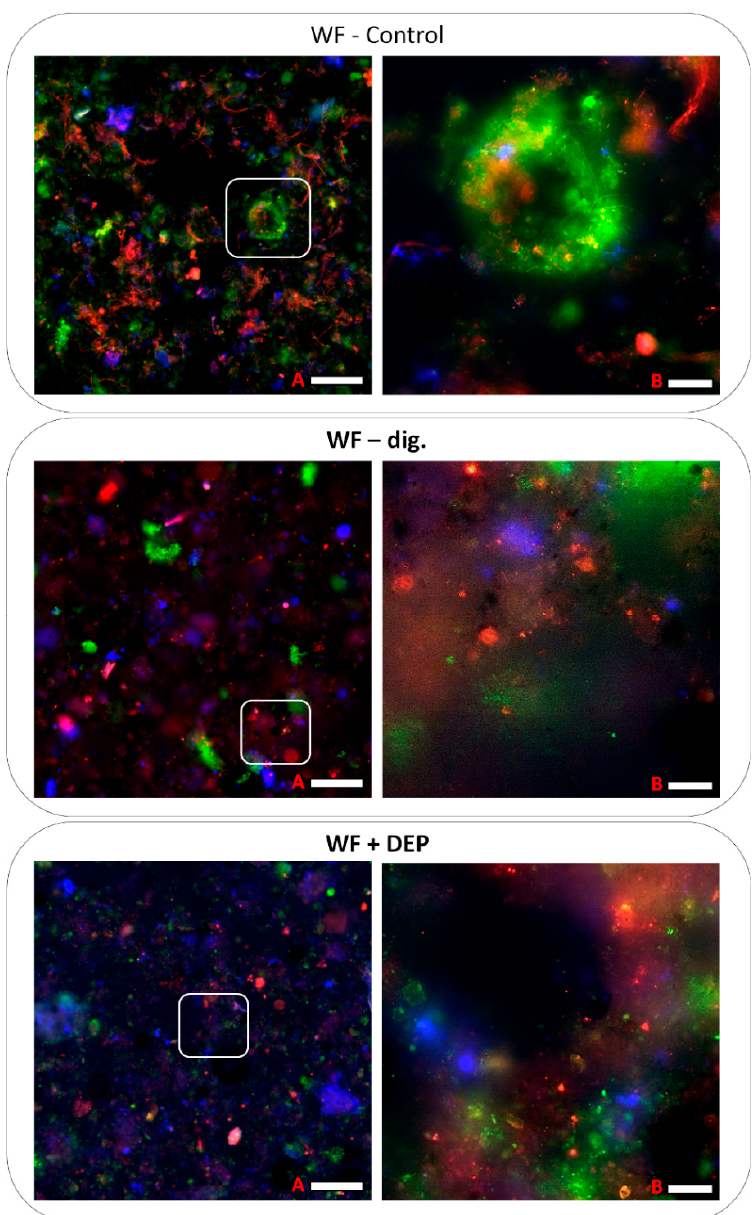
Figure 10. Visualisation of biofilms produced by the microbiome of raw research samples from the bioreactor. Green fluorescence—live cells; red fluorescence—dead cells; blue or pink fluorescence— carrier with bacteria. Scale bar A = 100 µm (left side) or B = 20 µm.